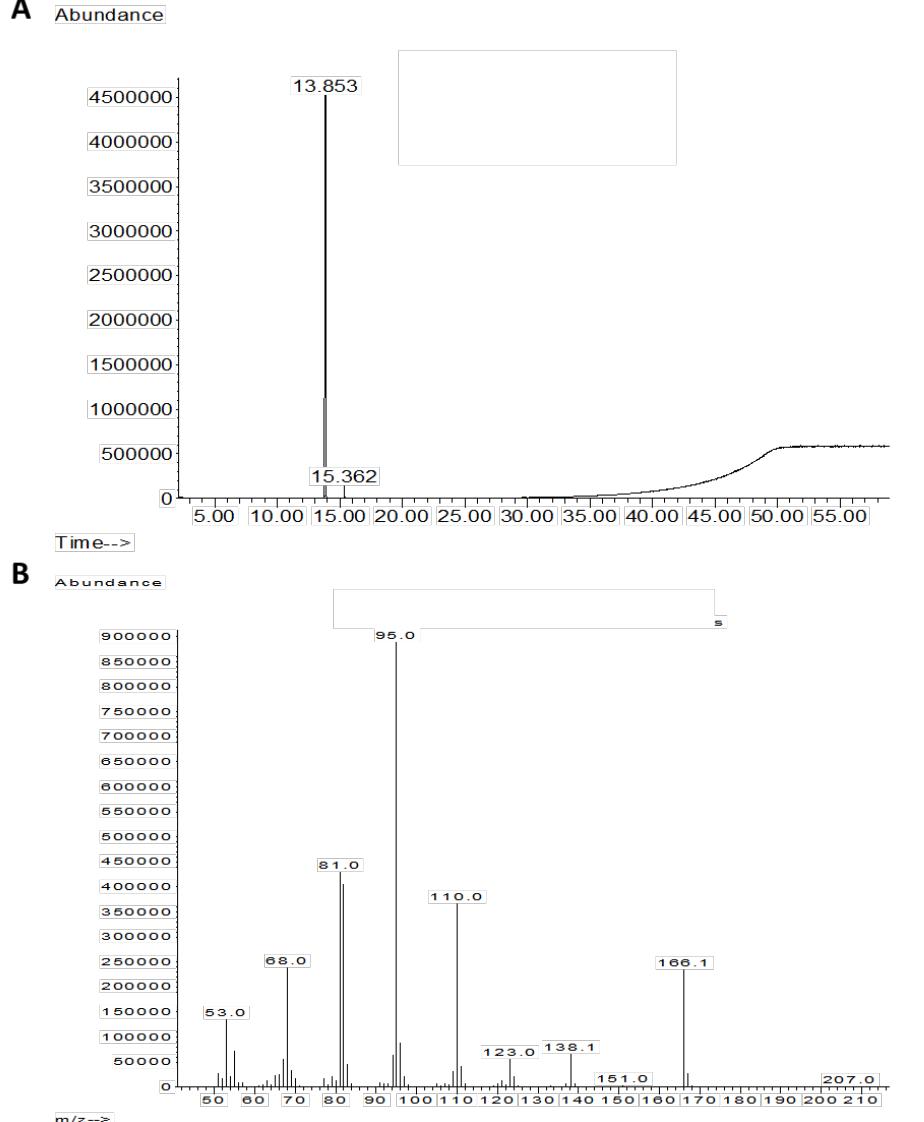
Figure 6. Identification of Trichoderma asperellum (P1) active ingredient(s) using GC-MS analysis. ( A ) GC–MS chromatogram and ( B ) MS spectra of the peak appearing at the chromatogram. Using the Willy library, the compound was identified as 6-Pentyl- α -pyrone (more than 95% fit between the